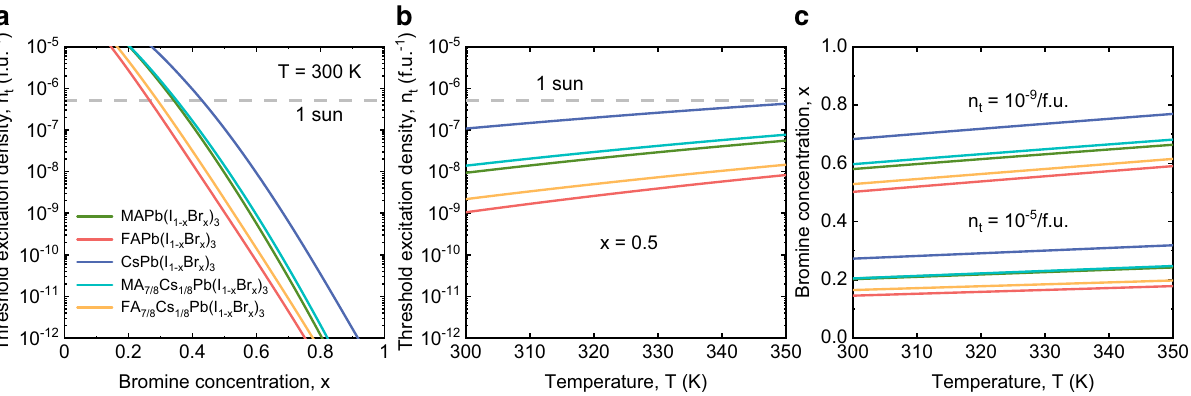
Fig. 4 Threshold photocarrier density for light-induced halide segregation. a Threshold photocarrier density n t for the different compounds at room temperature T = 300 K for light-induced halide segregation, as a function of Br concentration x . b Threshold photocarrier density as a function of temperature for x = 0.5. The horizontal dashed line in ( a ) and ( b ) indicates the photocarrier density n = 5 × 10 − 7 /f.u. in the mixed phase for about 1 Sun illumination. c Bromine concentration as a function of temperature at threshold photocarrier densities n t = 10 − 9 and 10 −